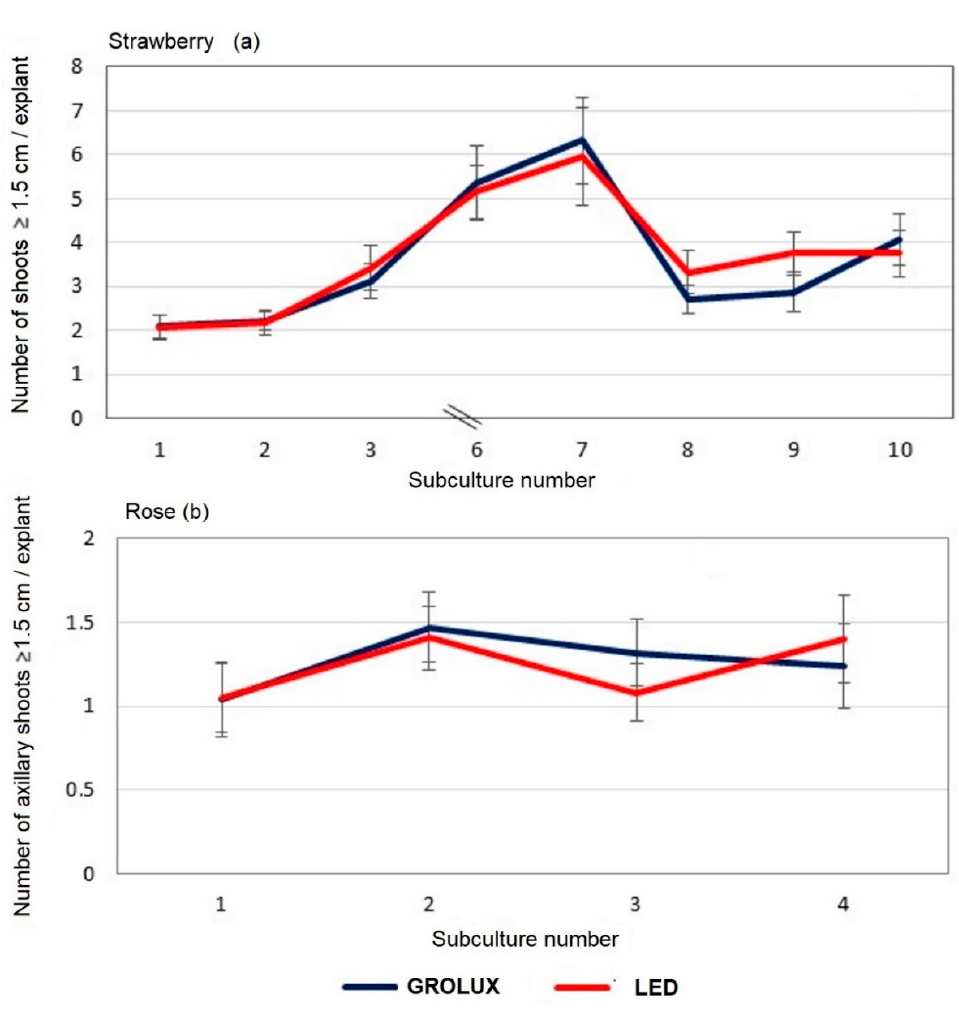
Figure 5. Effect of the light spectra on in vitro proliferation of ( a ) strawberry and ( b ) rose with Grolux fluorescent (blue line) and R + G + B LED equivalence (red line).